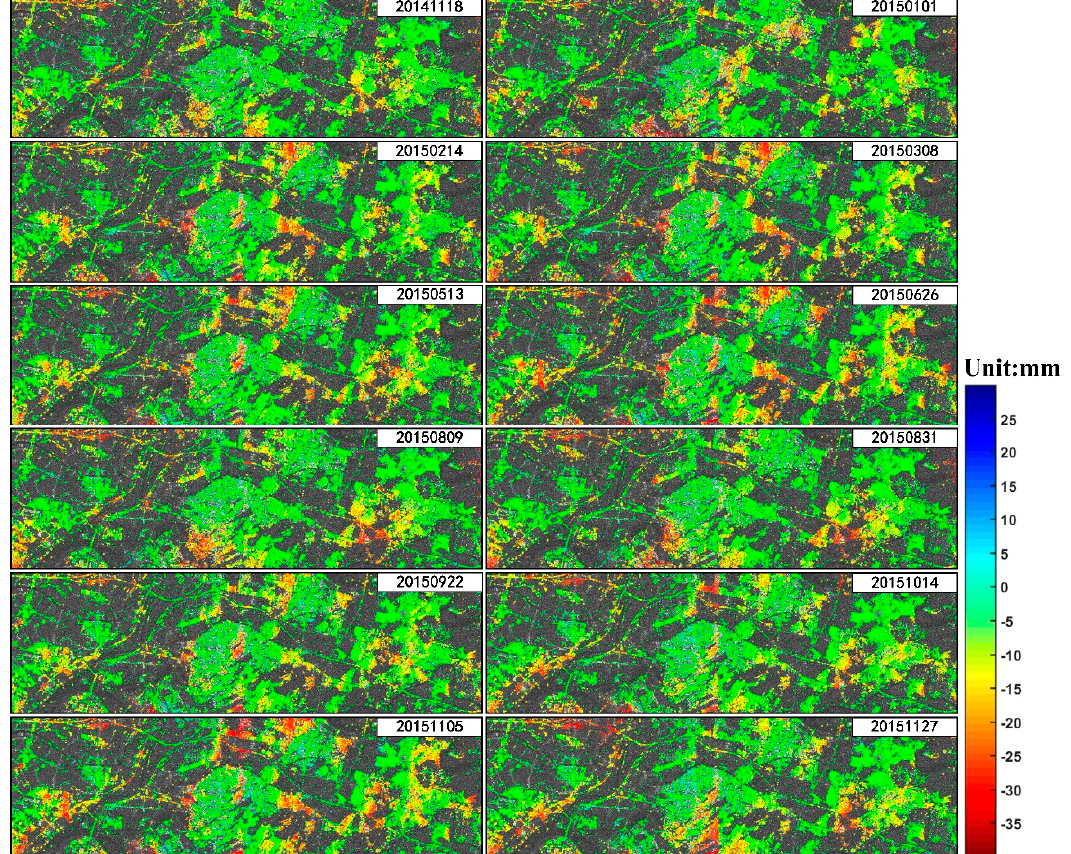
Figure 14. Time series deformation of G1501 Highway based on the linear model (referenced to 27 October 2014).